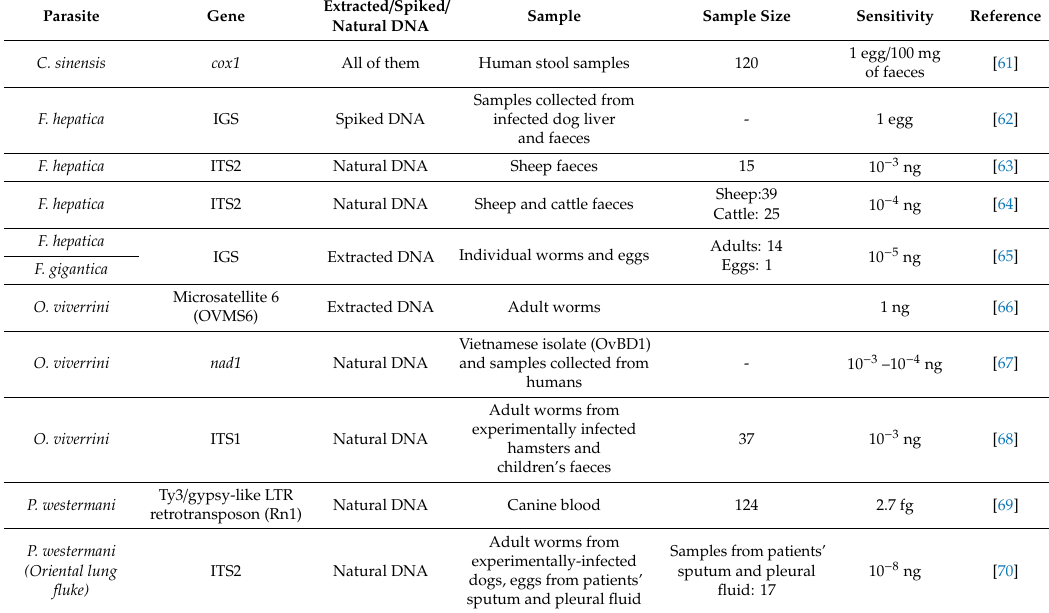
Table 4. Publications found in the US National Library of Medicine National Institutes of Health (NCBI-PubMed) reporting the standardisation of the LAMP technique as a useful tool for diagnosing foodborne trematodiases in the definitive